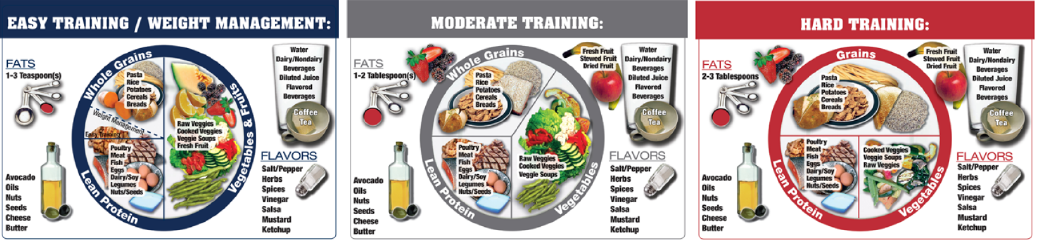
Figure 1. The Athlete’s Plate Nutrition Education Tool.